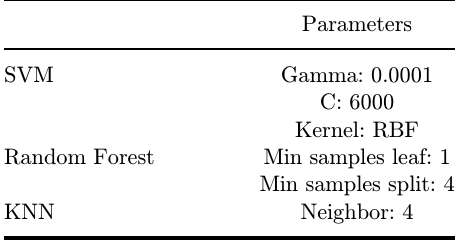
Table 3. Parameters of each classi¯er model.